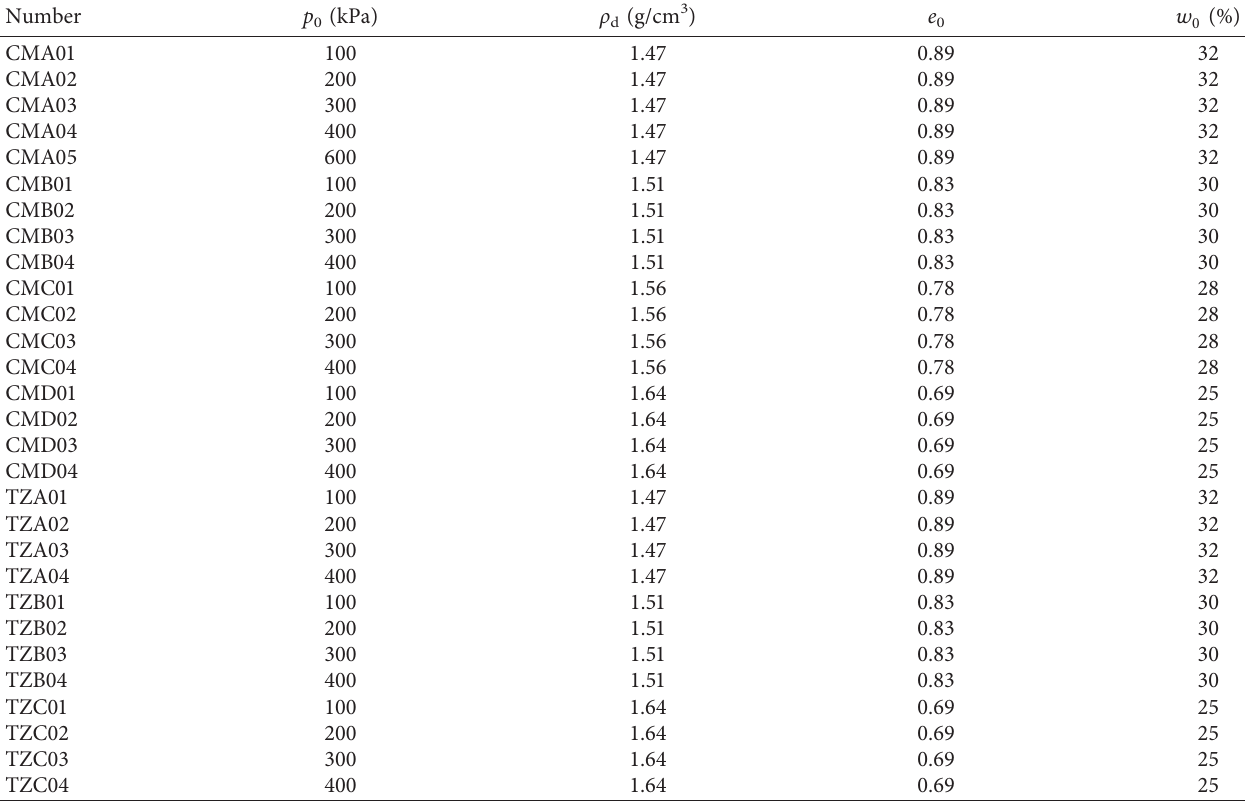
Table 3: Program of CU shear tests.